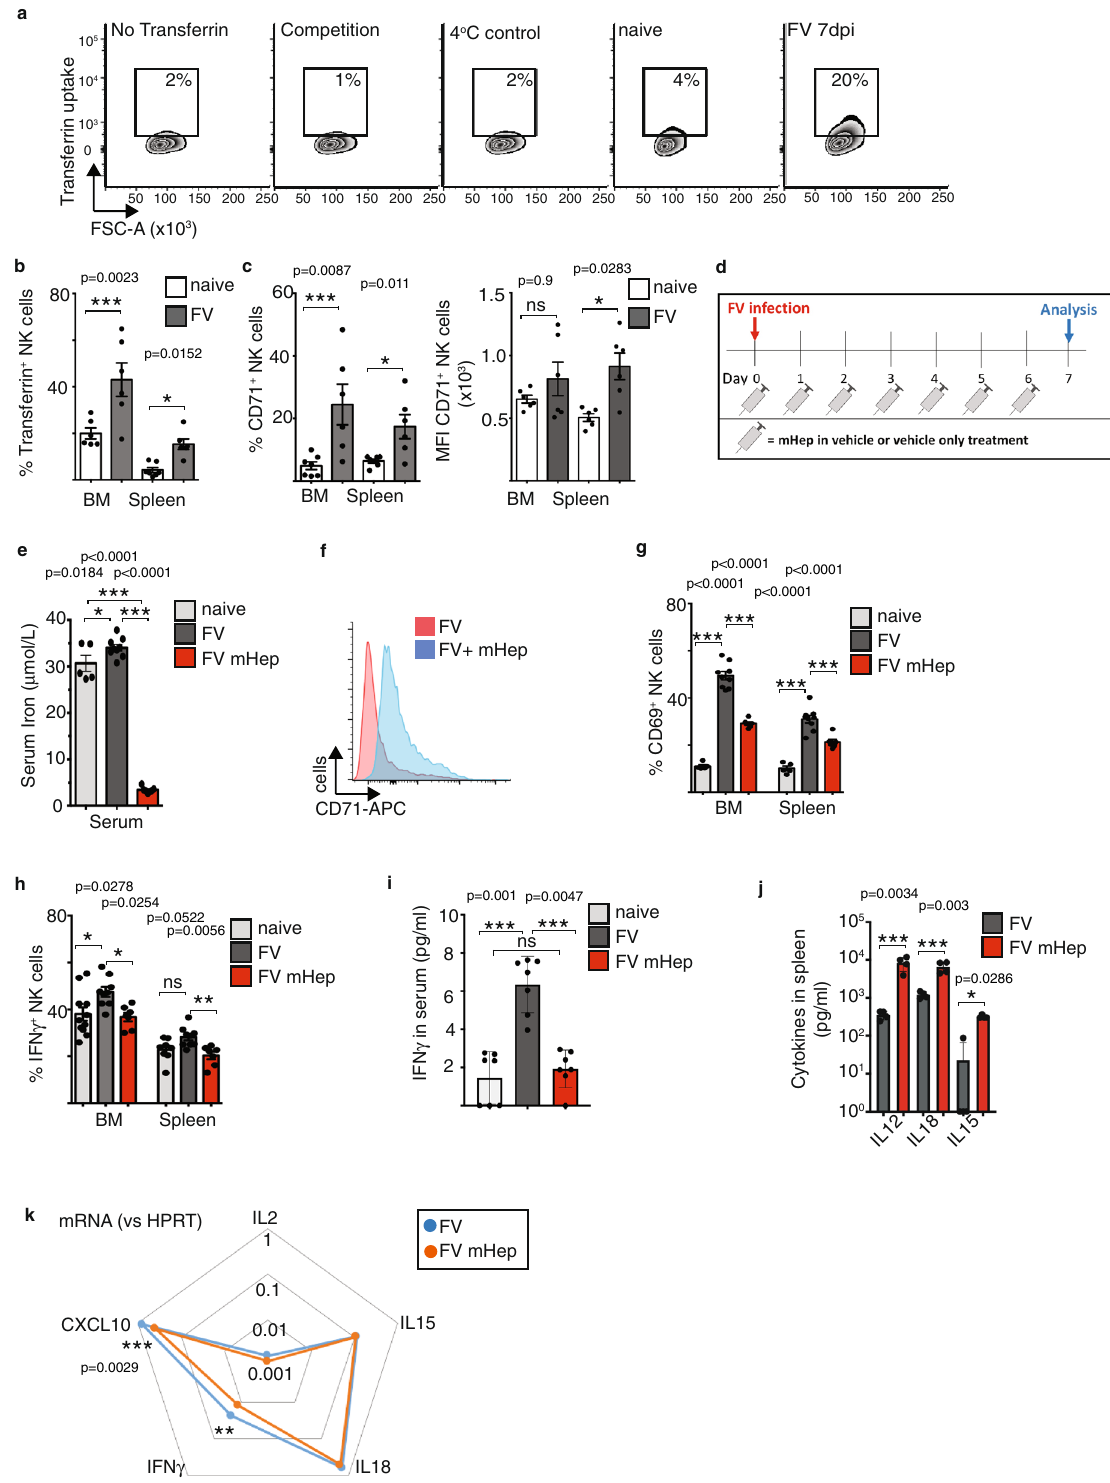
parameters of NK cells such as cell growth and cMyc expression. the spleen and bone marrow. We also discovered a dramatic Thus, we analysed the NK cell forward scatter as a measure of NK decrease of cMyc + NK cells in mice with low serum iron upon FV infection (Fig. 7b). To further explore the in fl uence of iron cell size in low serum iron groups and control mice. We detected de fi ciency on the NK cell capacity to kill target cells, we per- a smaller NK cell size in the FV-infected, iron-deprived group formed a cytotoxicity assay using FV-induced tumour cell targets compared to FV-infected, vehicle-treated mice (Fig. 7a). The (FBL-3 cells, Fig. 7c). NK cells isolated from infected mice with small cell size of these NK cells was comparable to that of NK low serum iron levels showed signi fi cantly less killing of FBL-3 cells from naive, vehicle-treated mice and was observed in both NATURE COMMUNICATIONS| (2021) 12:5376